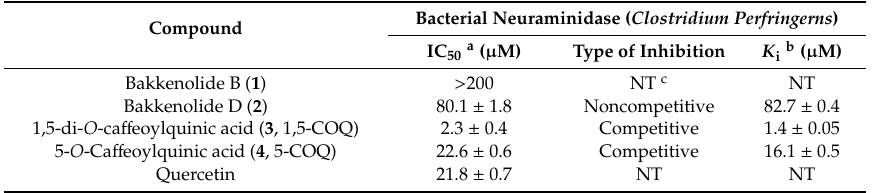
Table 1. Inhibitory effects of isolated compounds 1 – 4 on bacterial neuraminidase activities.